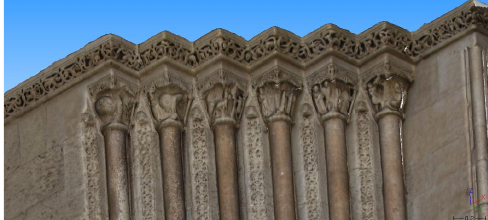
Figure 7: High resolution textured model with some white regions